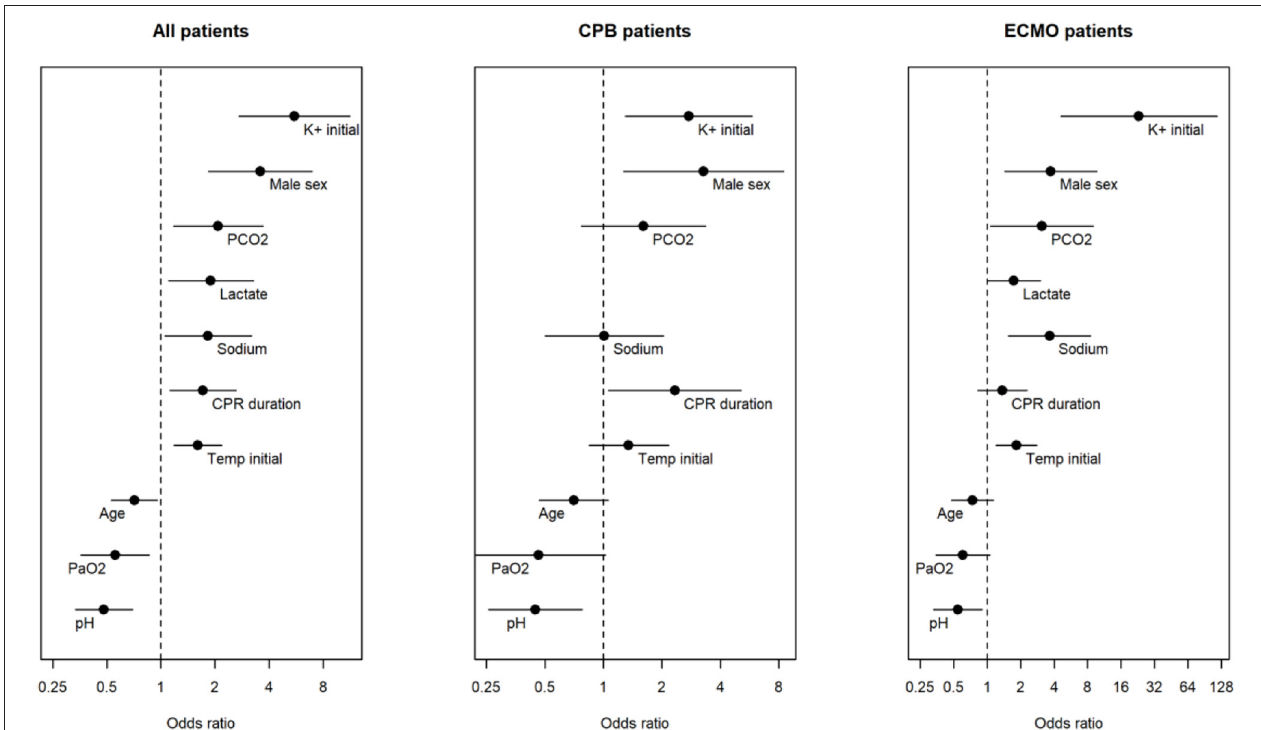
FIGURE 3 | Odds ratios of different variables from univariate logistic regression with death as outcome. From left to right, results from all patients from whom we had access to individual data, who underwent attempts on resuscitation by means of cardiopulmonary bypass (CPB) or extracorporeal membrane oxygenation (ECMO), respectively. Male sex and initial body temperature are per unit increase, while the rest are per standard deviation increase.